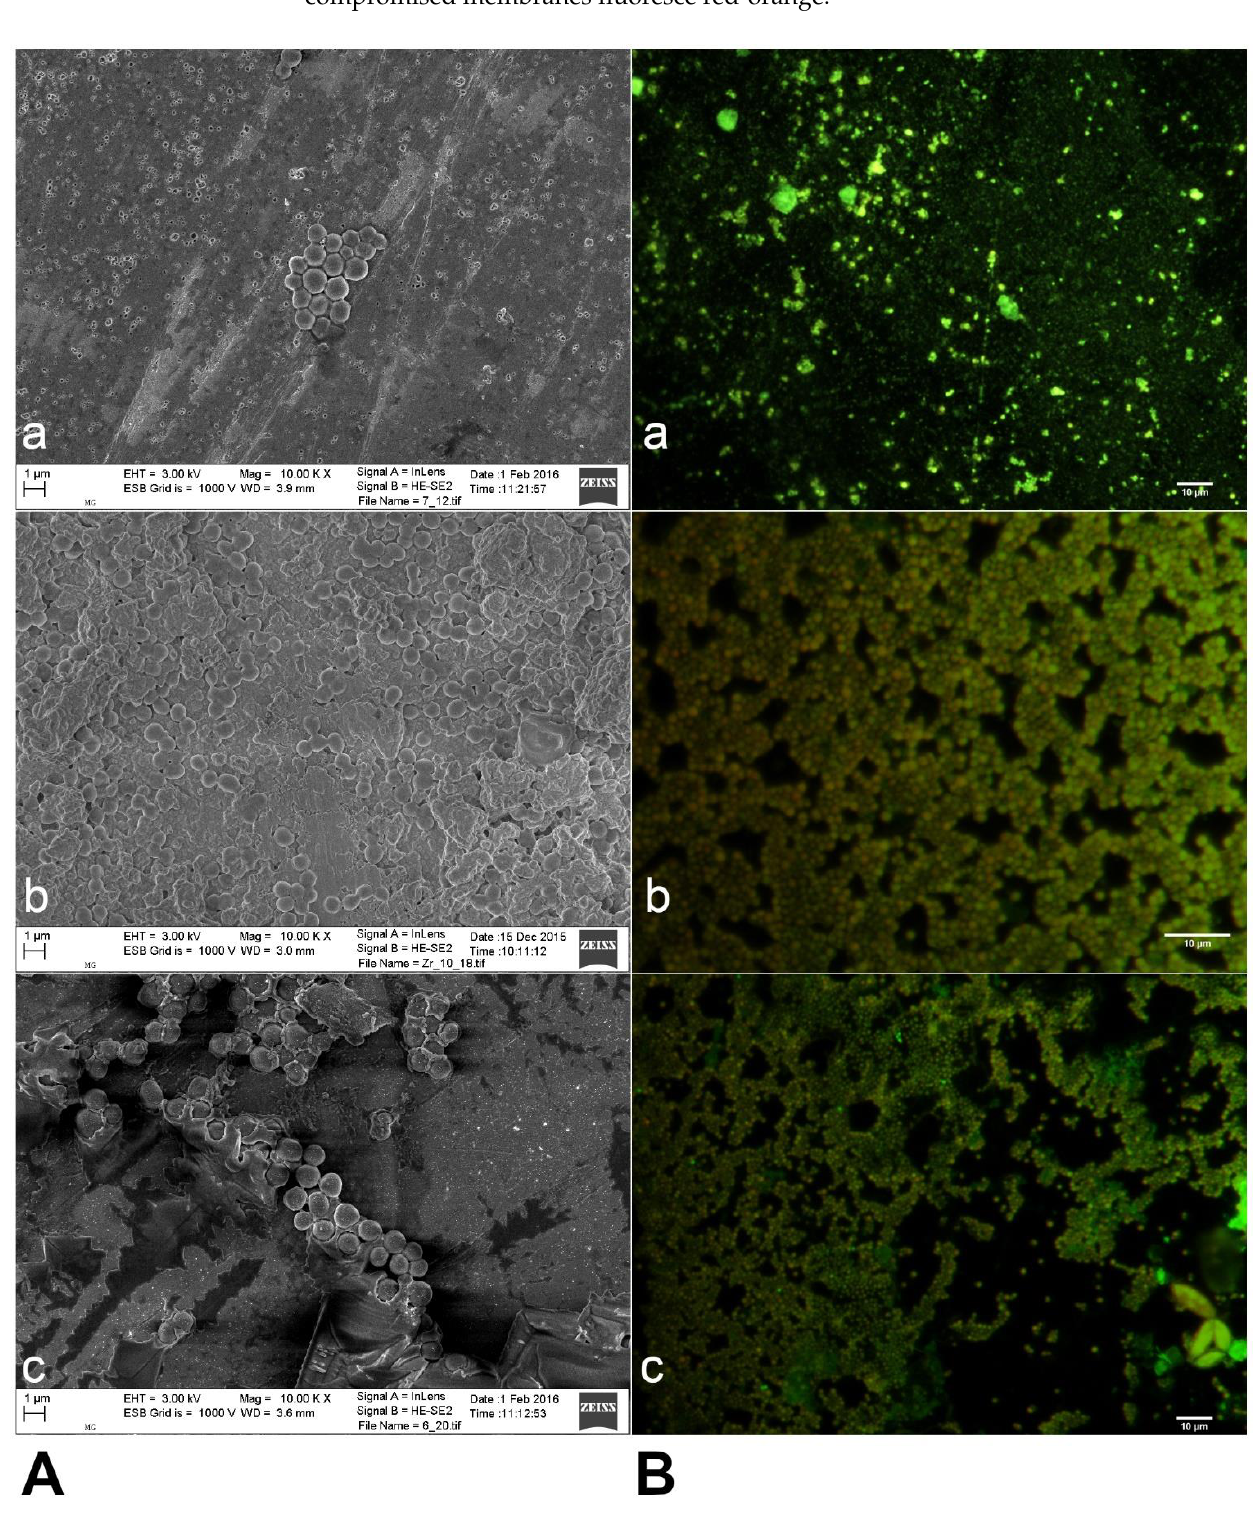
Figure 4. ( A ) Scanning electron microscopy images ( a – c ) of biofilms on different biomaterials. ( a ), Ti-6Al-4V (grade 5 titanium); ( b ) zirconium dioxide; ( c ) cobalt-chromium (CoCr) alloy (Duceralloy C). ( B ) Fluorescence microscopy images ( a – c ), after staining with a LIVE/DEAD BacLight kit on different biomaterials. ( a ) Ti-6Al-4V; ( b ) zirconium dioxide; ( c ) CoCr alloy (Duceralloy C). Original magnification ×10,000 (Scale bar = 1 μm).